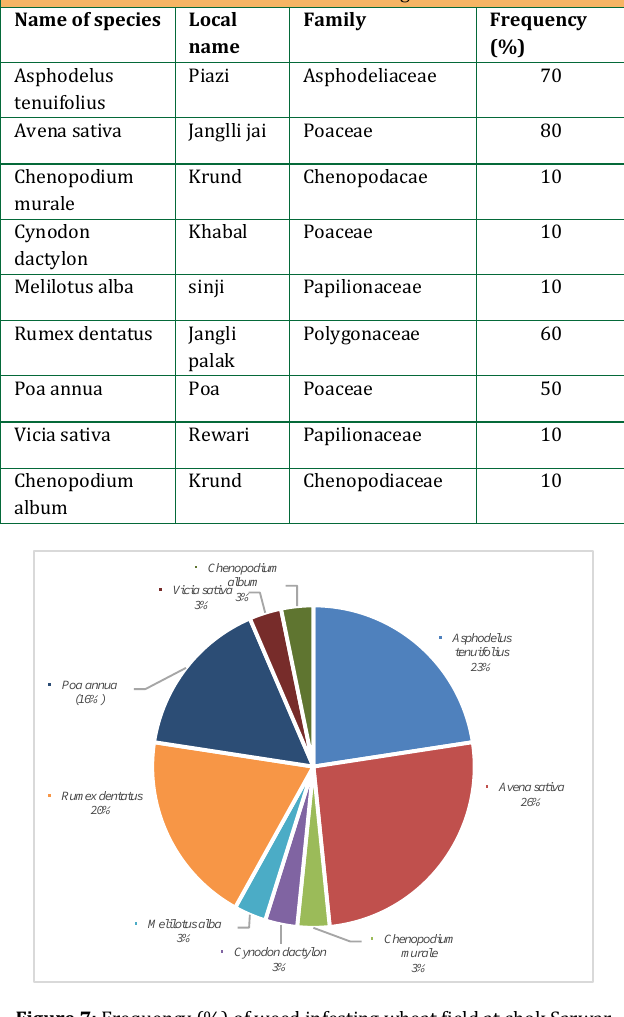
Figure 7: Frequency (%) of weed infesting wheat field at chok Sarwar Shaheed District